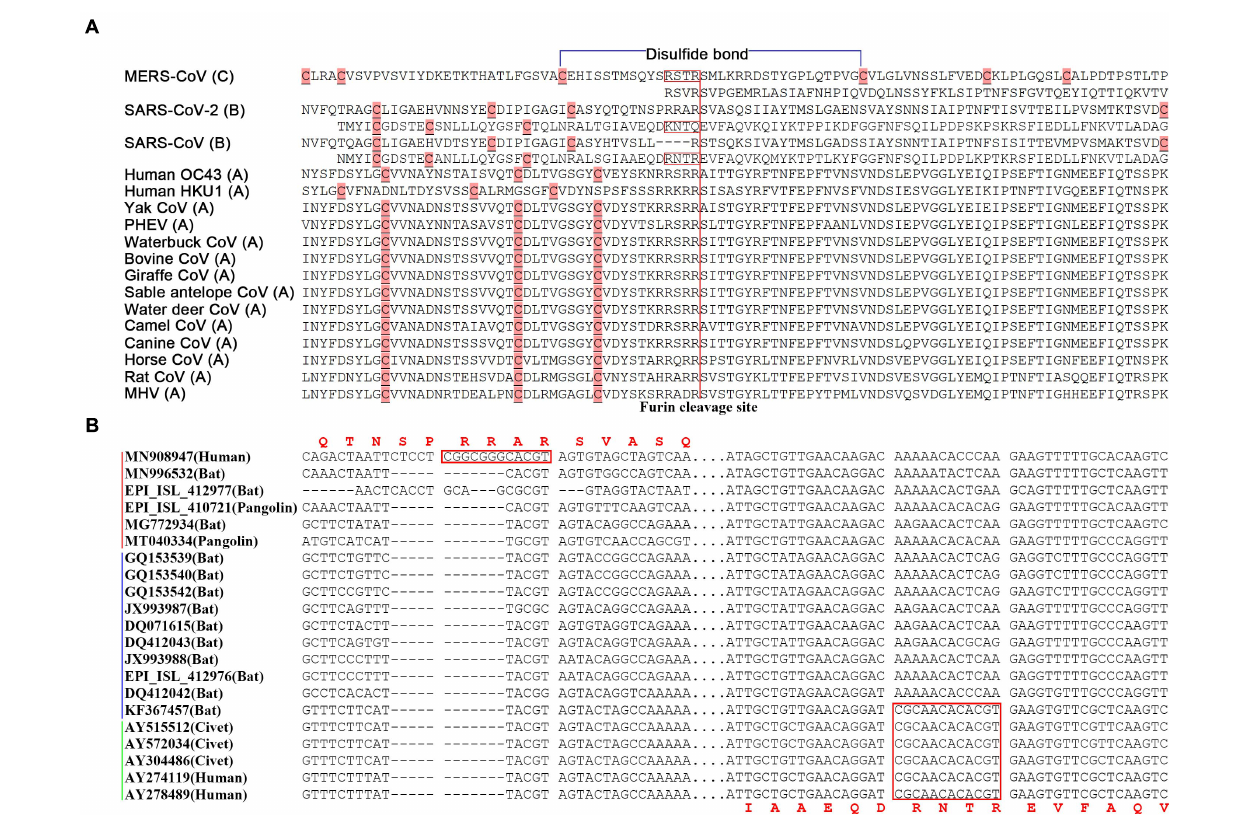
FIGURE 4 | Junction furin cleavage sites of betacoronaviruses. (A) Two regions having potential to contain junction furin cleavage sites (FCSs) are showed for MERS-CoV (R694 and R751), SARS-CoV-2 (R685 and Q779) and SARS-CoV (R667 and R761), while only one region is showed for other betacoronaviruses. Junction FCSs (in red box) are non-functioning, lost or inaccessible due to different reasons. The disulfide bond (in blue color) is only across “RSTR” of MERS-CoV. MERS-CoV (GenBank: JX869059) belongs to the subgroup C; SARS-CoV (GenBank: AY278489) and SARS-CoV-2 (GenBank: MN908947) belong to the subgroup B; Human OC43 (GenBank: KF530084), Human HKU1 (GenBank: KF686346), Yak CoV (GenBank: MH810163), PHEV (GenBank: KY419107), Waterbuck CoV (GenBank: FJ425186), Bovine CoV (GenBank: MH043954), Giraffe CoV (GenBank: EF424622), Sable antelope CoV (GenBank: EF424621), Water deer CoV (GenBank: MG518518), Camel CoV (GenBank: MN514963), Canine CoV (GenBank: JX860640), Horse CoV (GenBank: LC061274), Rat CoV (GenBank: JF792617) and MHV (GenBank: AF029248) belong to the subgroup A. PHEV: porcine hemagglutinating encephalomyelitis virus; MHV: mouse hepatitis virus. (B) Two regions having potential to contain junction FCSs (between spaces) are showed at the nucleotide level. The SARS-CoV-2&SARS2-like CoV, SARS-like CoV and SARS-CoV clusters were indicated by red, blue and green lines.